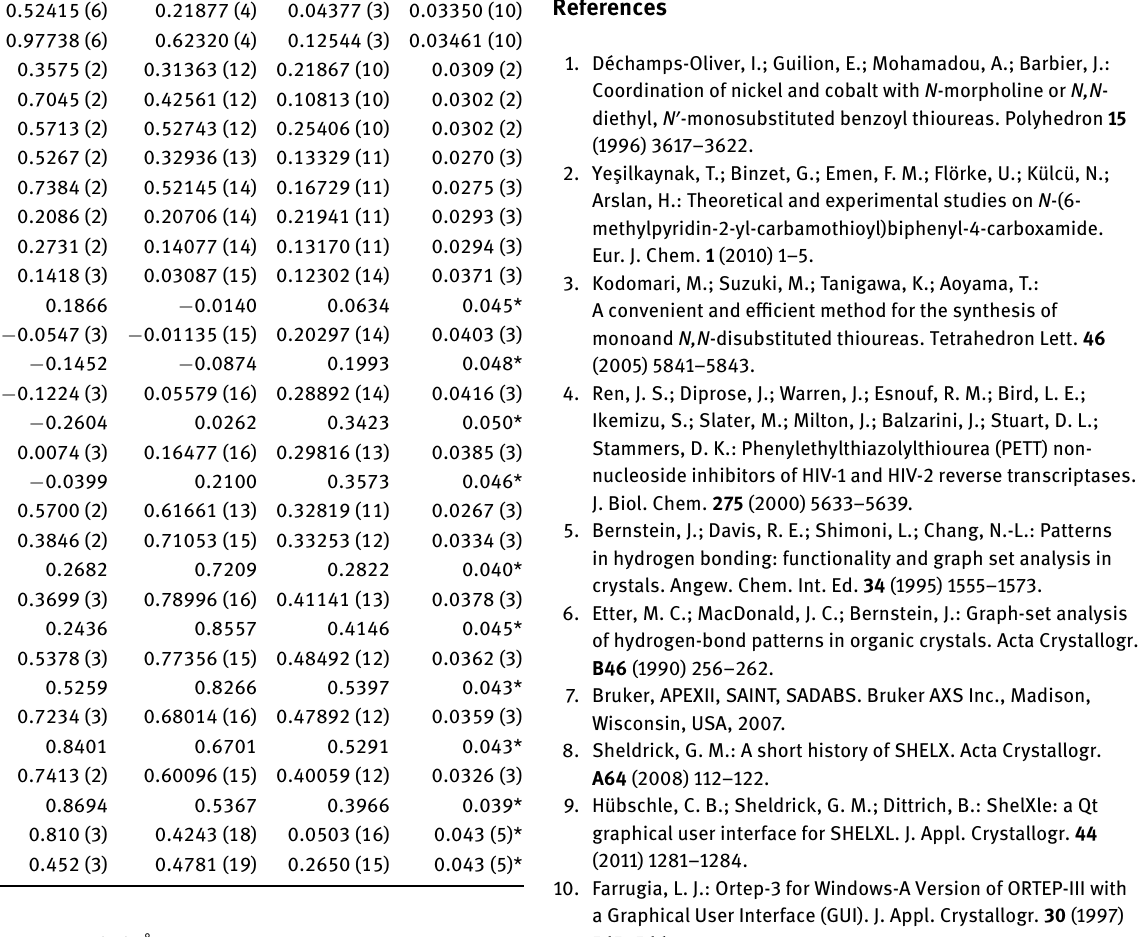
a length of 1.987(19) Å which in terms of graph-set analyses [5, 6] has a S 1 1 (6) descriptor always first order in a molecule without symmetry. Adjacent molecules have two N2—H2· · · S2 intermolecular bonds of 2.456(18) Å with a R 2 2 (8) descriptor on the unary level. The shortest π ring interaction is between adjacent phenyl C21—C26 rings with a centroid to centroid distance of 3.8800(9) Å and a slippage of 1.716